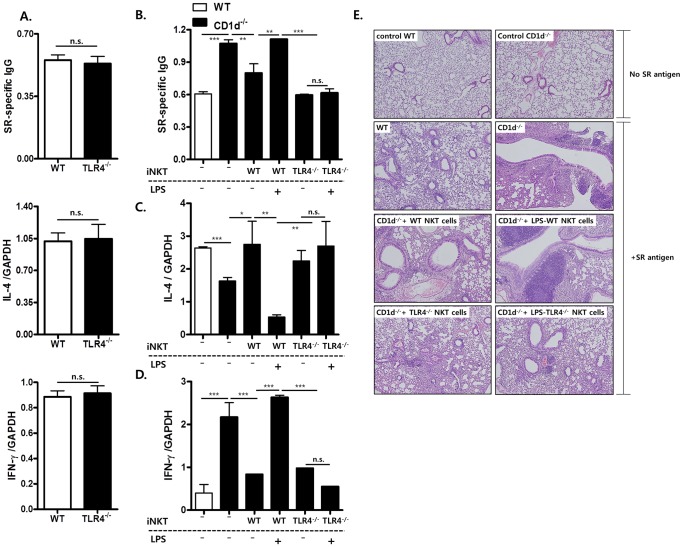
LPS-mediated engagement of TLR4 in iNKT cells aggravates Saccharopolyspora rectivirgula (SR)-induced hypersensitivity pneumonitis (HP).HP was induced by inoculating the SR antigen nasally. (A) The levels of SR-specific IgG in serum, and IL-4 and IFN-γ transcripts in the lungs of B6 or TLR4−/− mice were analyzed seven days after the first nasal inoculation of SR antigen using ELISA and real-time PCR, respectively. (B–D) B6, CD1d−/−, and CD1d−/− mice adoptively transferred with sorted iNKT cells (1×105 cells) from WT B6 or TLR4−/− mice were inoculated nasally with SR antigens. Sorted iNKT cells from B6 or TLR4−/− mice were incubated with LPS or PBS for 30 min before adoptive transfer into CD1d−/− mice. (B) These mice were sacrificed three weeks after induction of HP, and SR-specific IgG levels in serum were determined. (C) IL-4 and (D) IFN-γ levels were measured in the bronchoalveolar lavage fluid from B6, CD1d−/−, and CD1d−/− mice adoptively transferred with sorted iNKT cells from B6 or TLR4−/− mice seven days after inoculation of the first SR antigen by ELISA. (E) Histological examination of the lungs was performed 7 days after first SR treatment (×100). (A–D) Data are from a representative of three repeated experiments. (n = 4 in A, n = 3 in B, C, D; *p<0.05, **p<0.01, ***p<0.001).